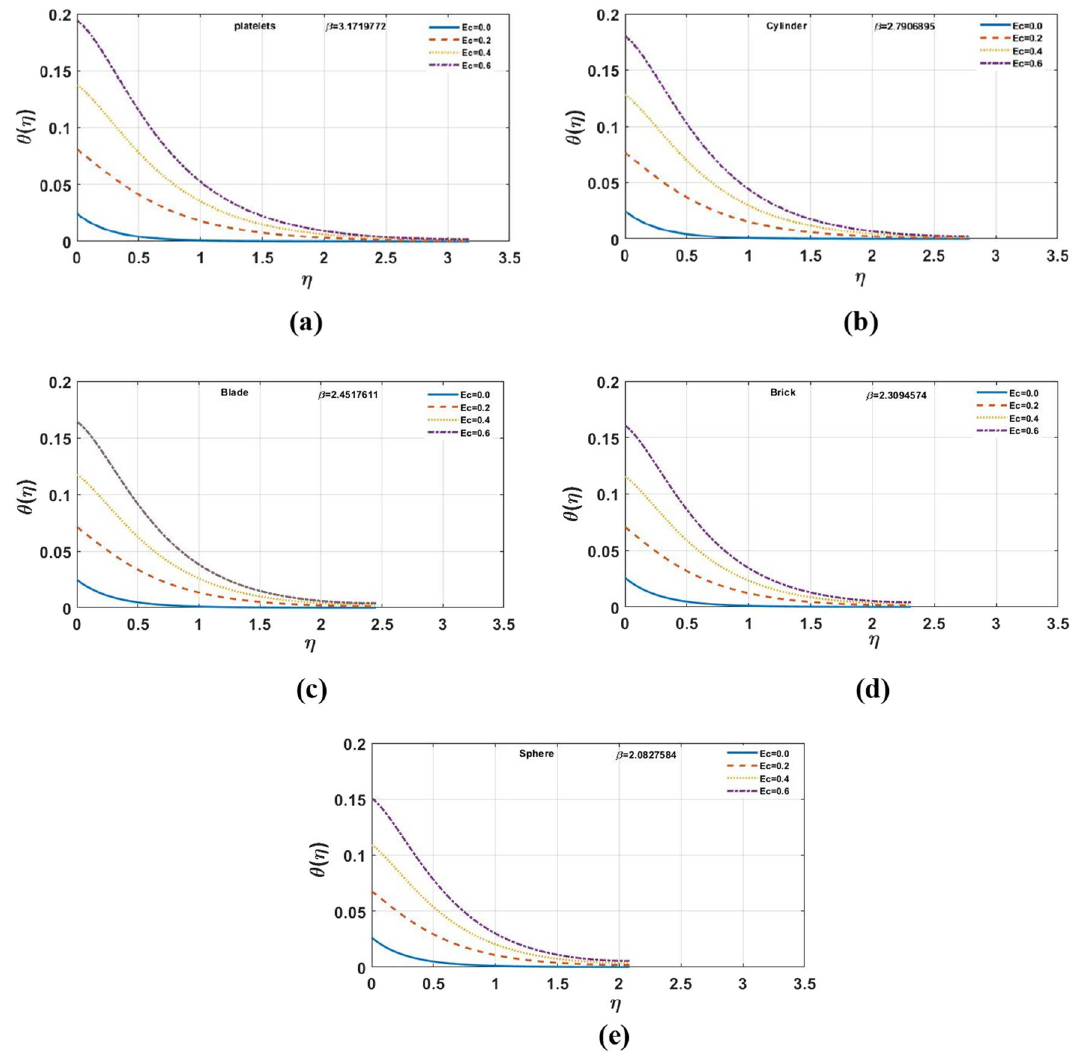
0.4 , M 1.0 , K 0.5 , ϕ 0.02 , γ 0.1 , Pr = = = = = =